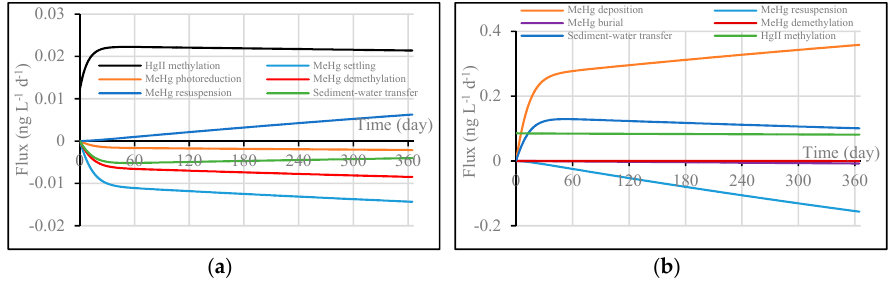
Figure 6. W2 computed MeHg internal fluxes in the water column ( a ) and the sediment layer ( b ). To investigate individual Hg transformations, solid sorption, settling, resuspension, and sediment-water transfer processes were turned off. Figure 7a,b show dissolved concentrations of HgII and MeHg in the water column. Figure 8a,b show Hg transformation fluxes respectively. W2 predicted concentrations of HgII and MeHg are consistent with WASP model results. Dissolved HgII was lost by its reduction and methylation in the water column. In the meantime, MeHg was gained and reached the peak around 50 days, then decreased by its demethylation and photoreduction. The above case studies indicate that the algorithms and formulations were correctly implemented in the enhanced W2 model.